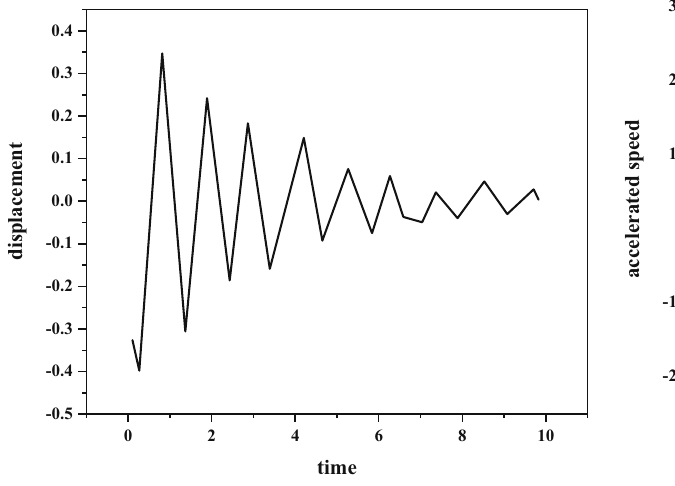
Figure 1: O ff set time history. Figure 3: Historical acceleration time curve.